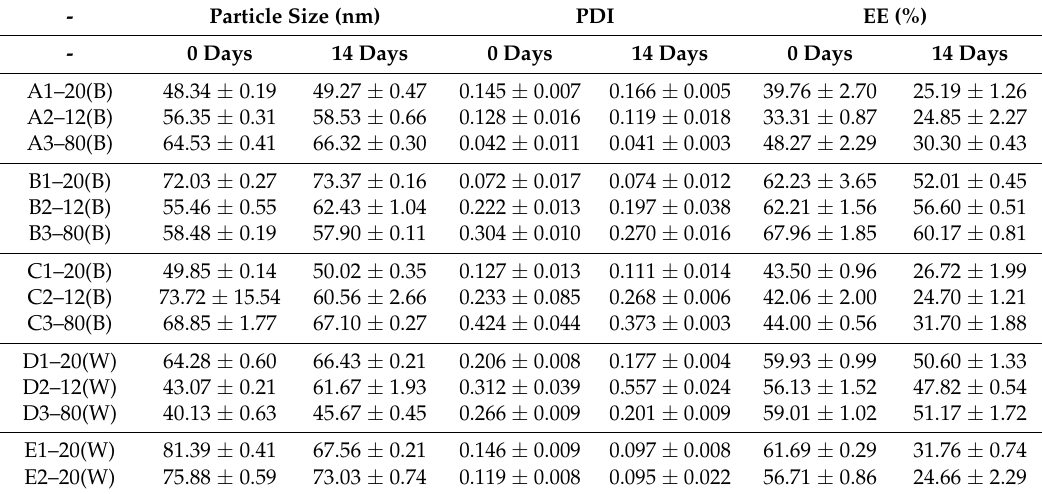
Table 1. Entrapment efficiency (EE) and particle sizes of transfersomes.